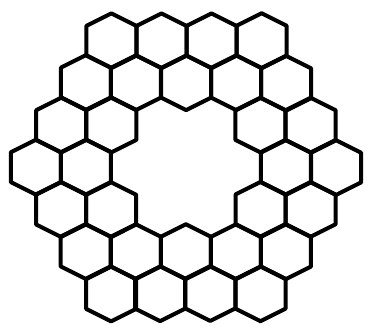
Figure 2. Kekulenes